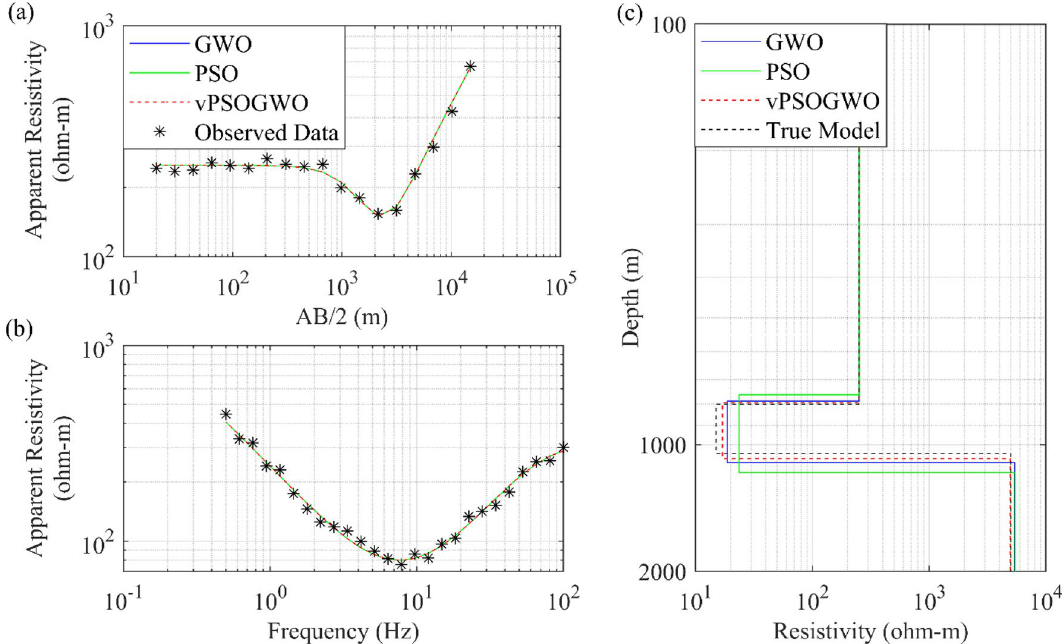
Figure 10. Three-layer noisy DC and MT synthetic apparent resistivity data: ( a ) observed (*) and the best-fitted curves using vPSOGWO, GWO, and PSO; ( b ) 1D mean model (bpdf > 68.27% CI) inverted by vPSOGWO (red), GWO (blue) and PSO (green) with an actual model (black).